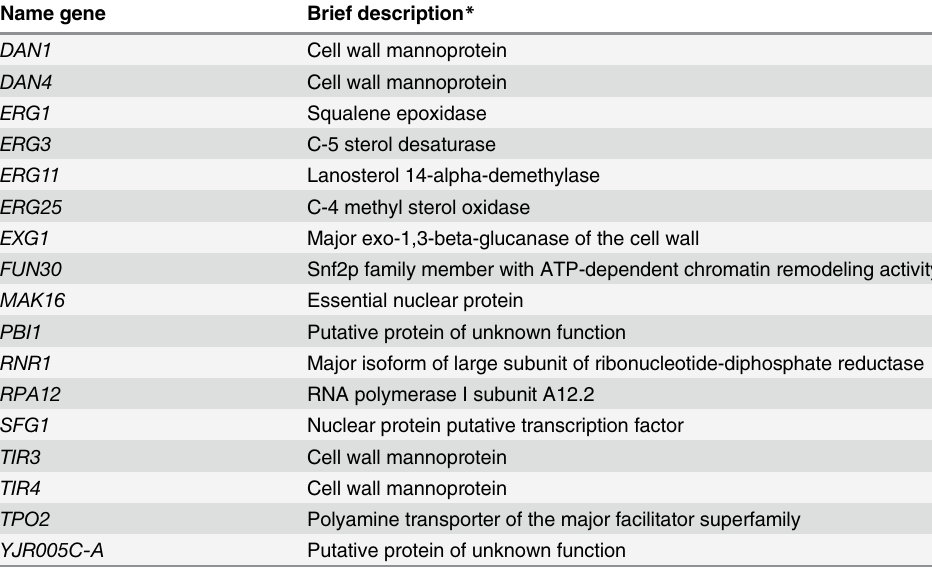
Table 1. Genes with higher expression levels in cells that harbored pTOW-Rear2 compared with the control